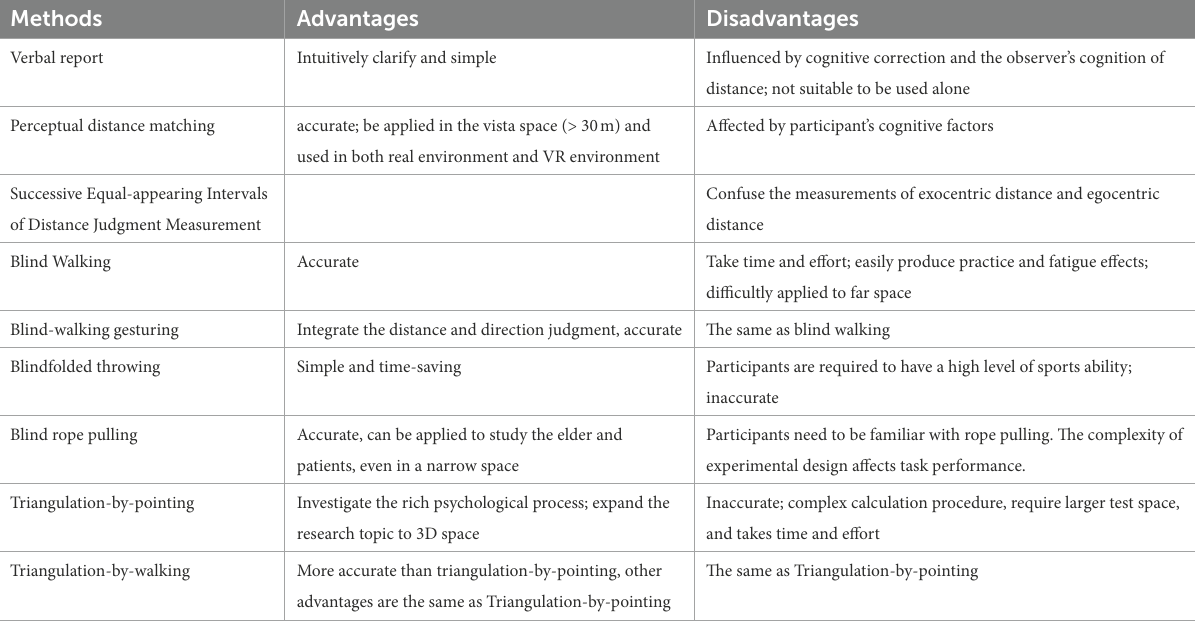
TABLE 1 The summary of advantages and disadvantages of each method for measuring distance